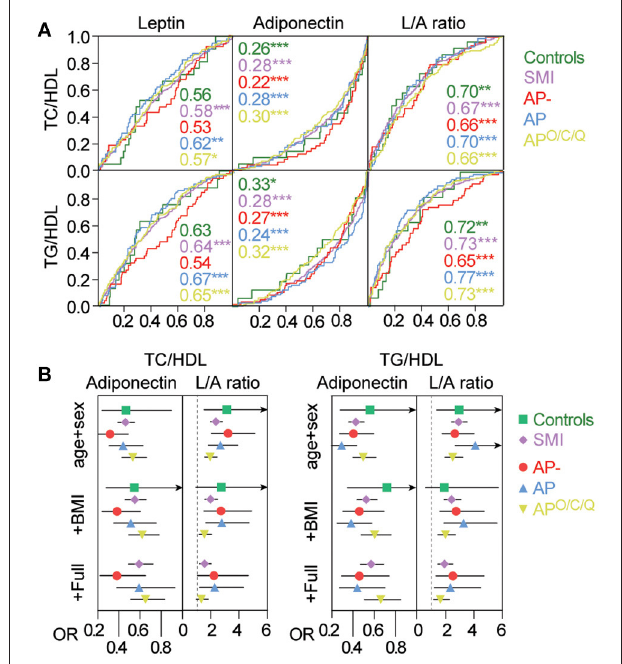
FIGURE 1 | Leptin, adiponectin and their ratio (L/A) in severe mental illness (SMI) and according to antipsychotic (AP) treatment. To the left: multivariate analysis of covariance with dependent variable: leptin (A) , adiponectin (B) or L/A (C) , with adjustment for age, sex, duration of illness, mood stabilizers (DDD), duration of AP treatment and additional adjustment with body mass index (BMI). * p < 0.05 ** p < 0.01 *** p < 0.001 vs. healthy controls; † p < 0.05, †† p < 0.01, ††† p < 0.001 vs. AP-. To the right: correlation between log-transferred leptin, adiponectin or L/A, and BMI. Numbers indicate the regression coefficient. *** p < 0.001.